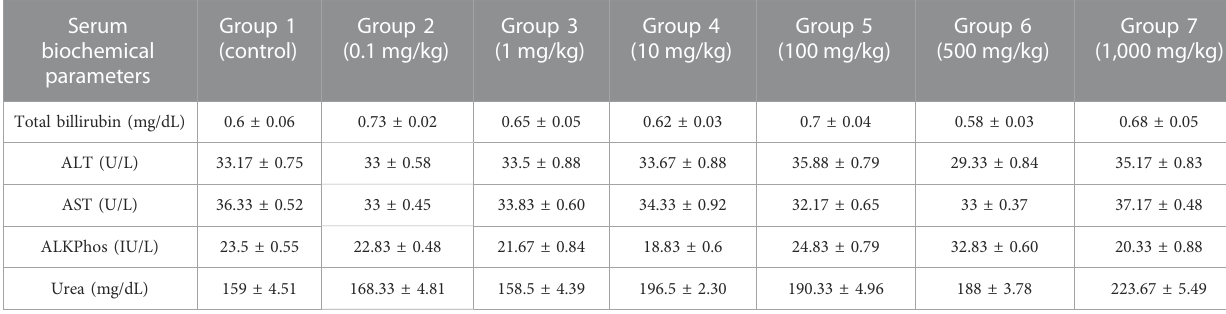
TABLE 10 Subacute toxicity study of biomarkers of liver malfunction in mice. Serum